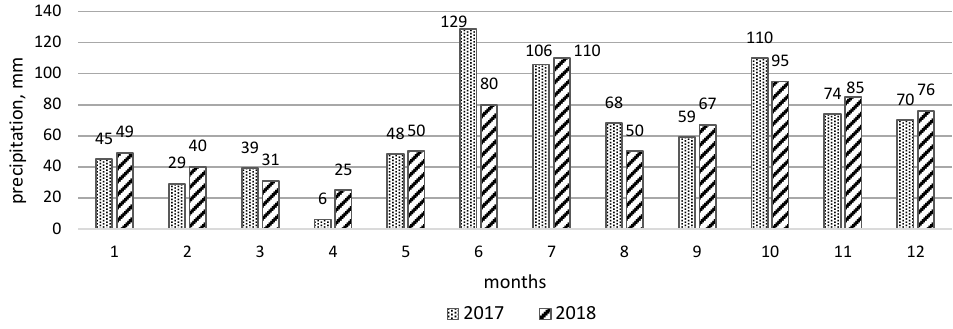
Figure 2. Varying quantities of precipitation in 2017 and 2018. (1—January, 2—February, ... 12—December). [38,39].